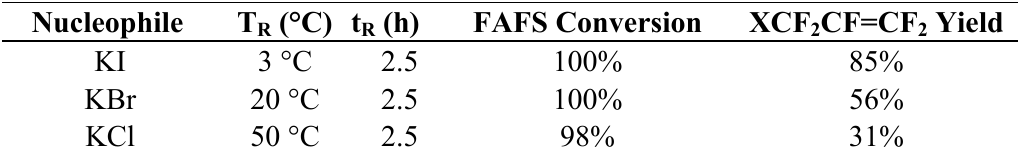
Table 11. Allyl halide yield as a function of the